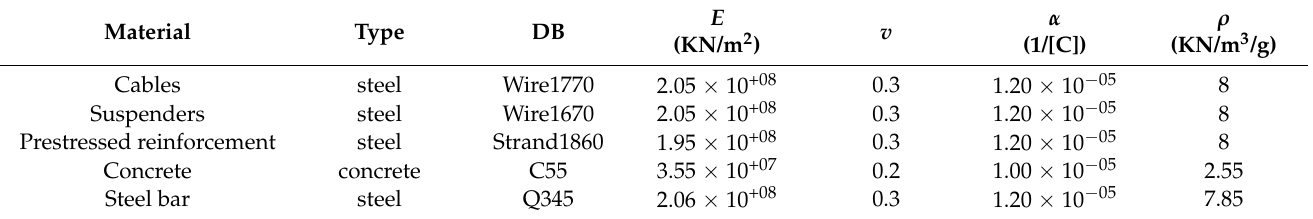
Table 1. Material data of the example bridge.